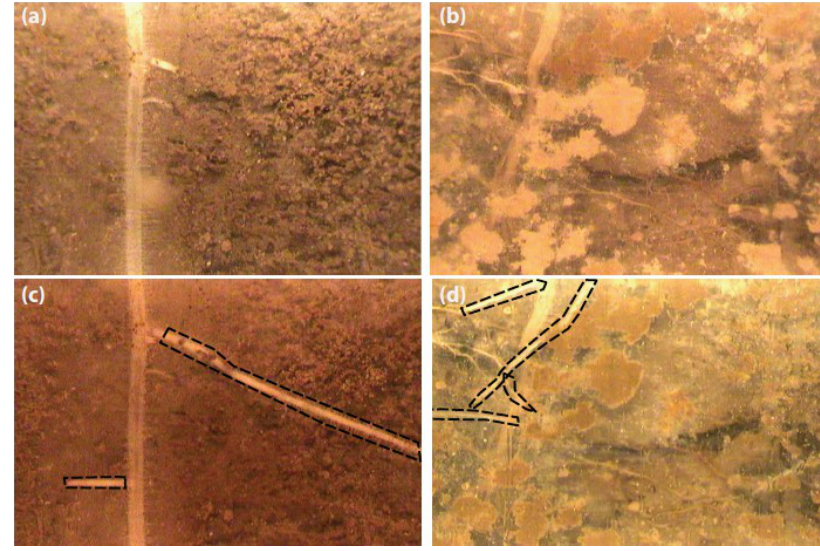
Figure 2. Images collected from the minirhizotron. One set was collected at the 25 cm minirhizotron tube depth (17 cm vertical soil depth) in ( a ) May 2011 and ( c ) June 2011. The second set was collected from the 5 cm minirhizotron tube depth (3.5 cm vertical soil depth) in ( b ) December 2011 and ( d ) January 2011. Roots boxed by dashed lines indicate newly appearing roots based on the previous month’s